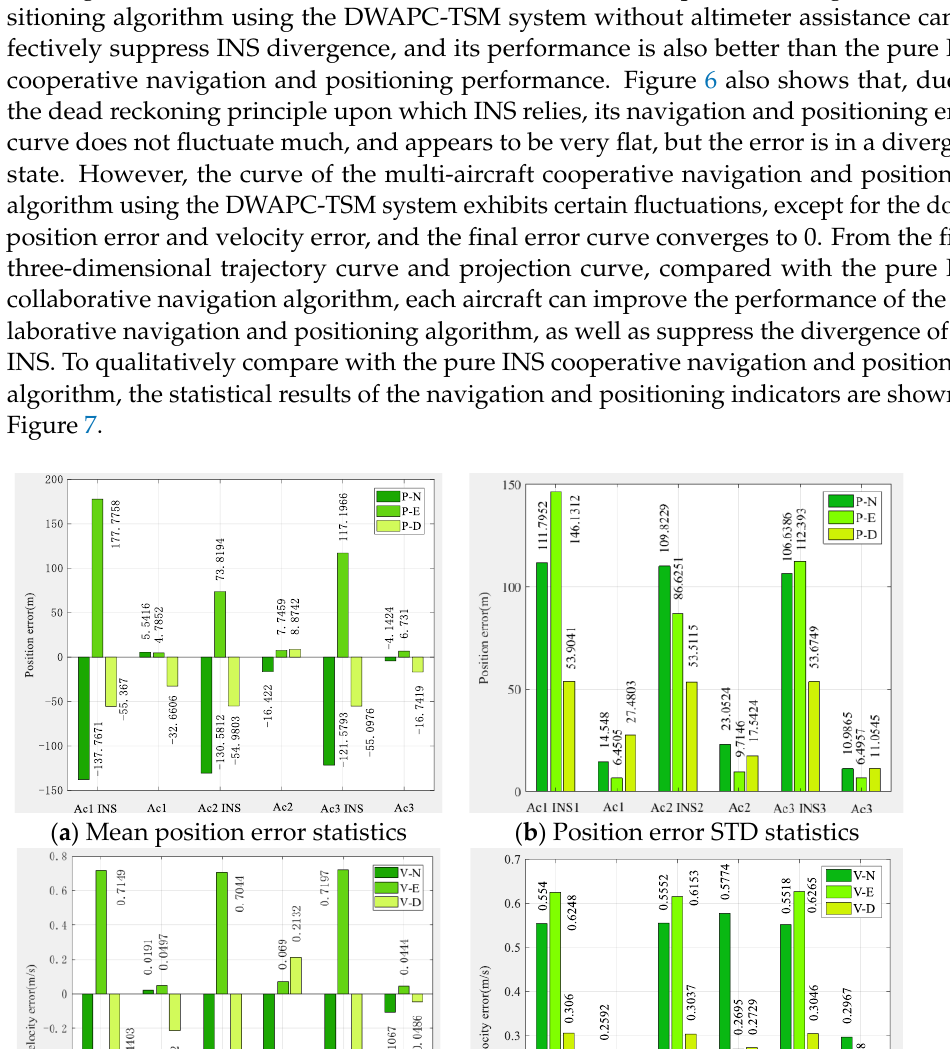
Figure 6. Navigation and positioning error curve of multi-aircraft cooperative navigation in the DWAPC-TSM system without altimeter assistance.